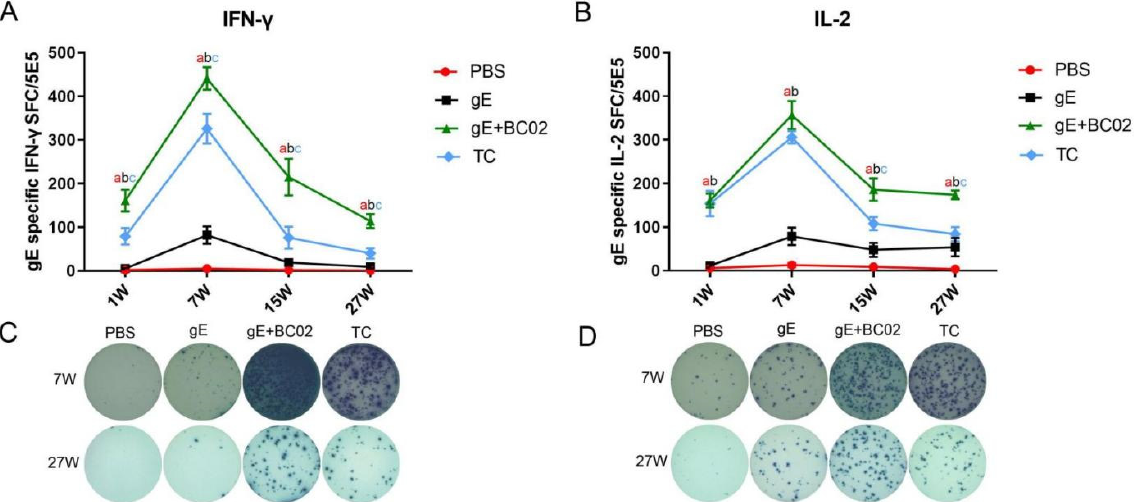
Figure 2. BC02-adjuvanted experimental vaccine induces gE antigen-specific cellular immune re- sponse. ( A , B ) Mean numbers of gE-specific IFN- γ and IL-2 spot forming cells (SFC) in immunized mice 1, 7, 15, or 27 weeks post immunization determined by ELISpot. Six mice per immunization group. ( C , D ) Representative images of gE-specific IFN- γ and IL-2 secreting T cells in mice 7 and 27 weeks post-immunization with BC02-adjuvanted gE glycoprotein. a,b,c: Indicates significant sta- tistical difference between gE+BC02 and PBS, gE or TC, respectively. p < 0.05. TC is the abbreviation of test